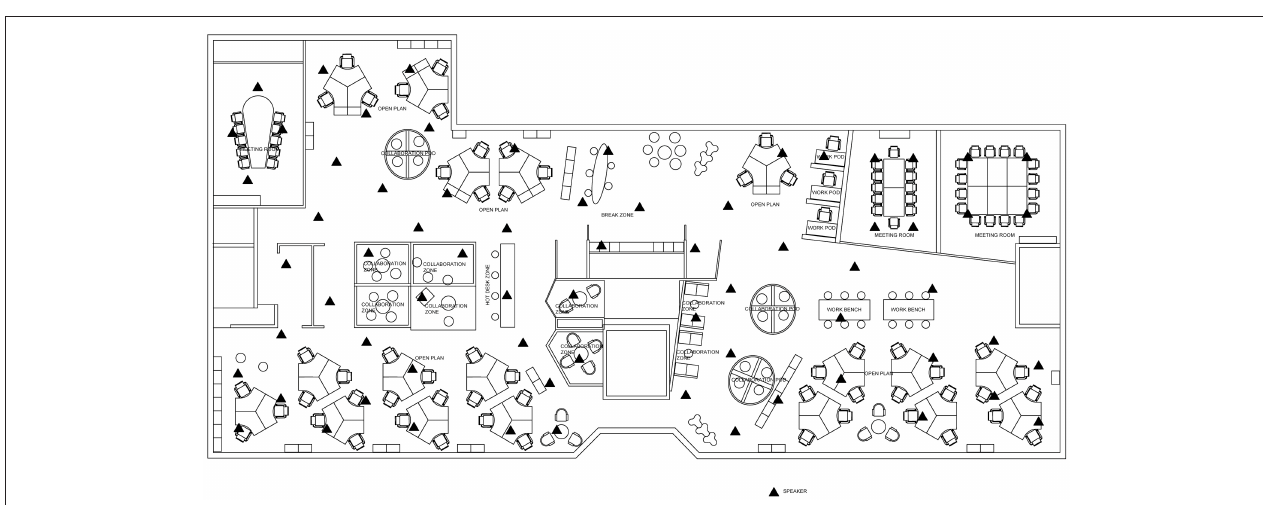
Frontiers in Psychology |